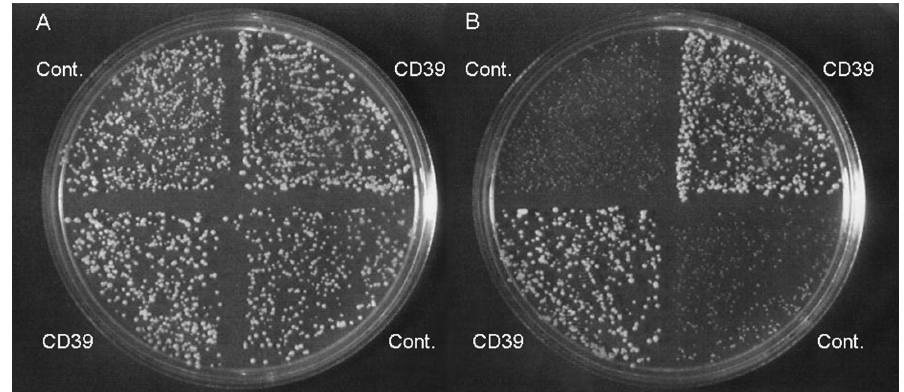
Figure 1 . Growth of acid phosphatase-negative yeast strain on uracil-de fi cient medium supplemented with phosphate or ATP. The cells of the yeast strain carrying pVT101-CD39 (CD39) or pVT101 (Cont.) were streaked on a synthetic minimal DO-U medium plate contain- ing phosphate (A) or 0.3 mM ATP at pH 7.2 as phosphate source (B). A total of 10 μ l of a cell culture OD 650 = 0.1 was plated on both plates. The plates were incubated at 30°C for 3